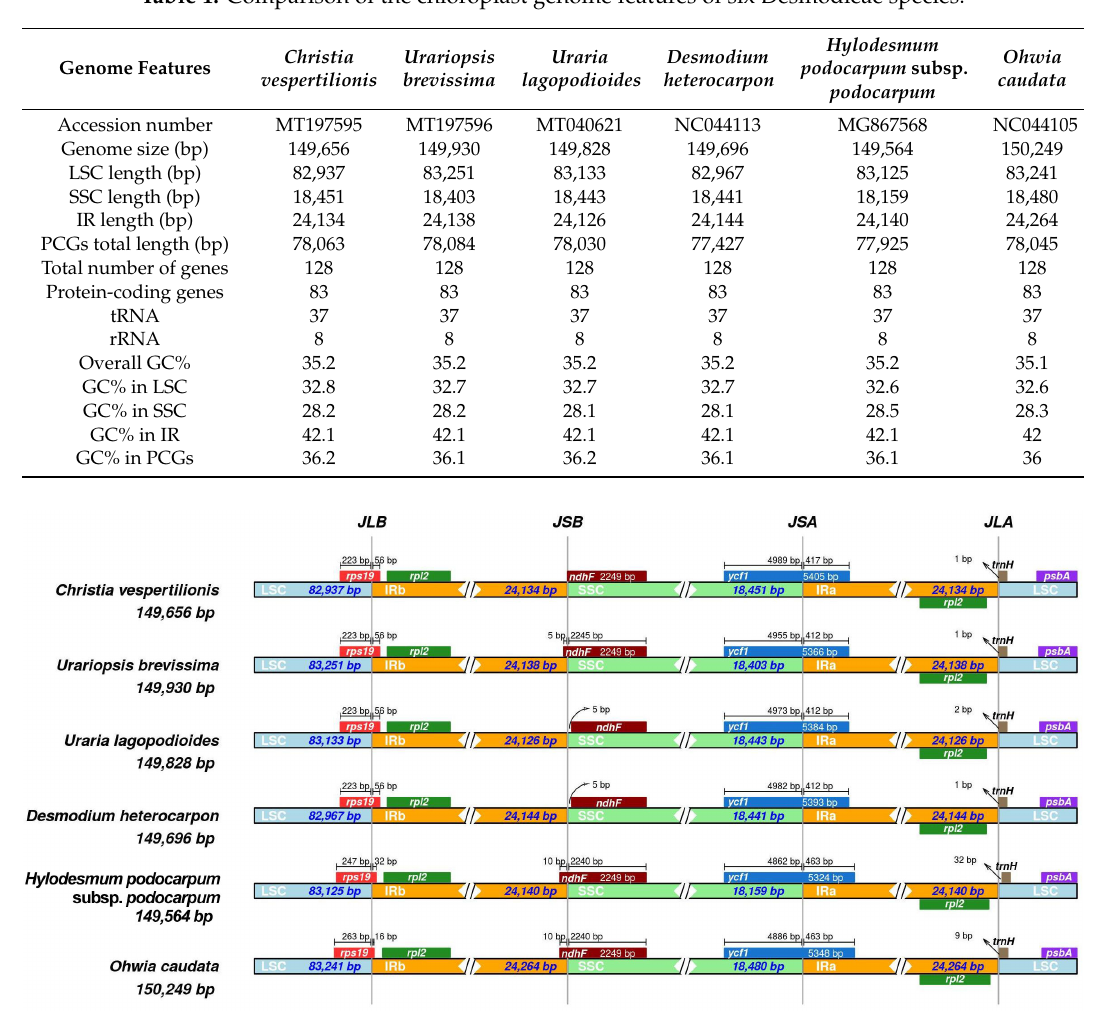
Table 1. Comparison of the chloroplast genome features of six Desmodieae species.